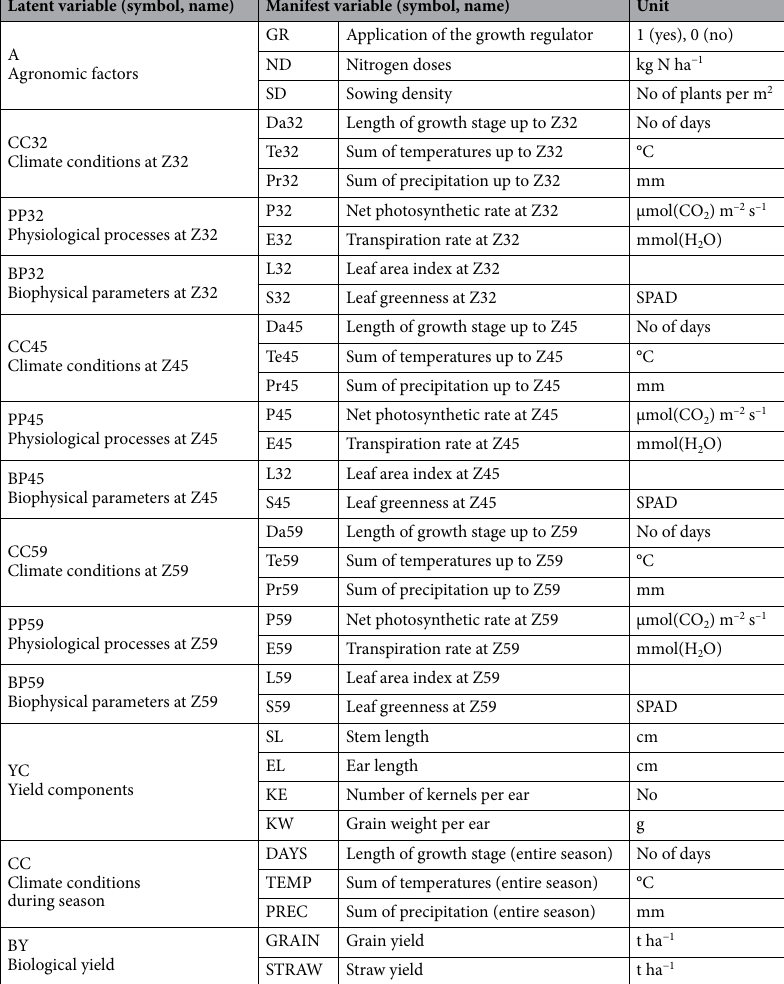
Table 4. The notation for variables in Partial Least Square Path Modeling